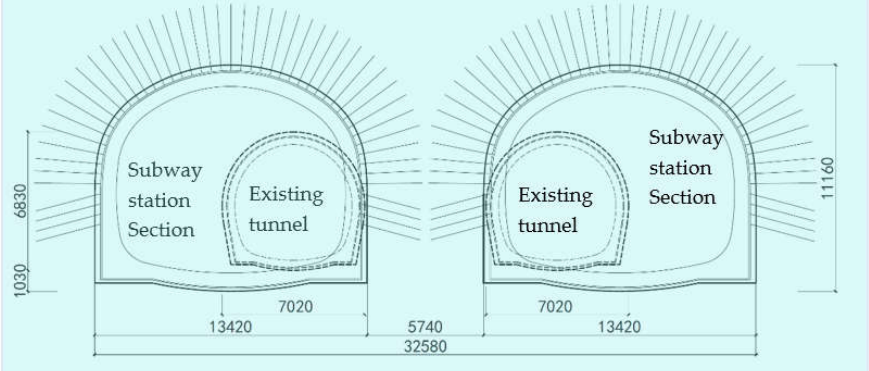
Figure 2. A schematic diagram of in situ expansion excavation method for subway station (unit: mm).